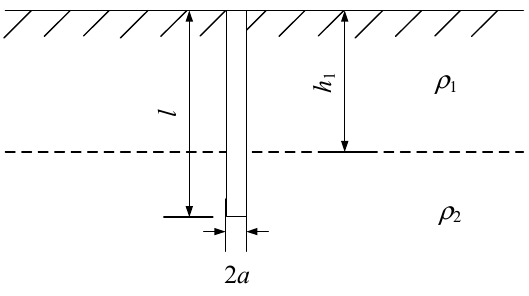
Figure 2. Grounding model of offshore WT.